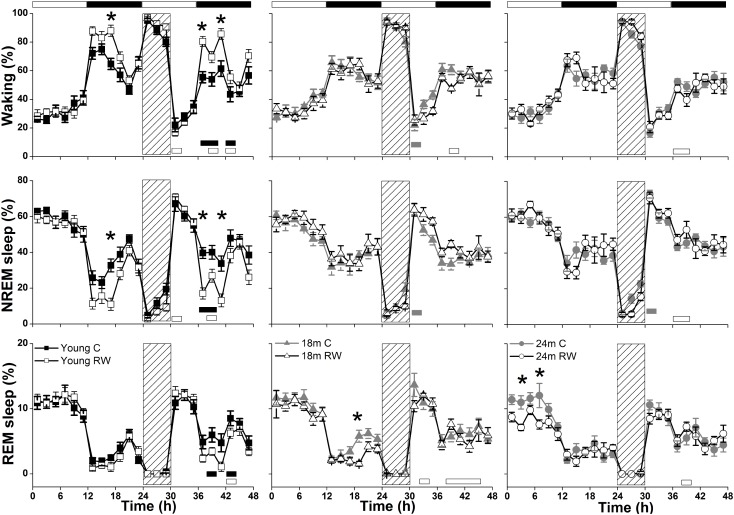
Time course of vigilance states, for 24-h baseline (BL), 6-h sleep deprivation (SD, hatched bar) and 18-h recovery for 6, 18, and 24 months old control and running-wheel (RW) mice (left, middle, and right, respectively). Curves connect 2-h mean values (±SEM) of Waking, NREM and REM sleep. The black and white bars above each graph indicate the light-dark cycle. Asterisks at the top of each graph represent significant differences between control and wheel access groups across the 48-h period and bars at the bottom of each graph significant differences between recovery and BL day for each age and condition (post hoc unpaired and paired t-tests with Bonferroni multiple comparisons correction, p < 0.05 after significant ANOVAs, main effects ‘treatment,’ ‘time of day,’ ‘day’).